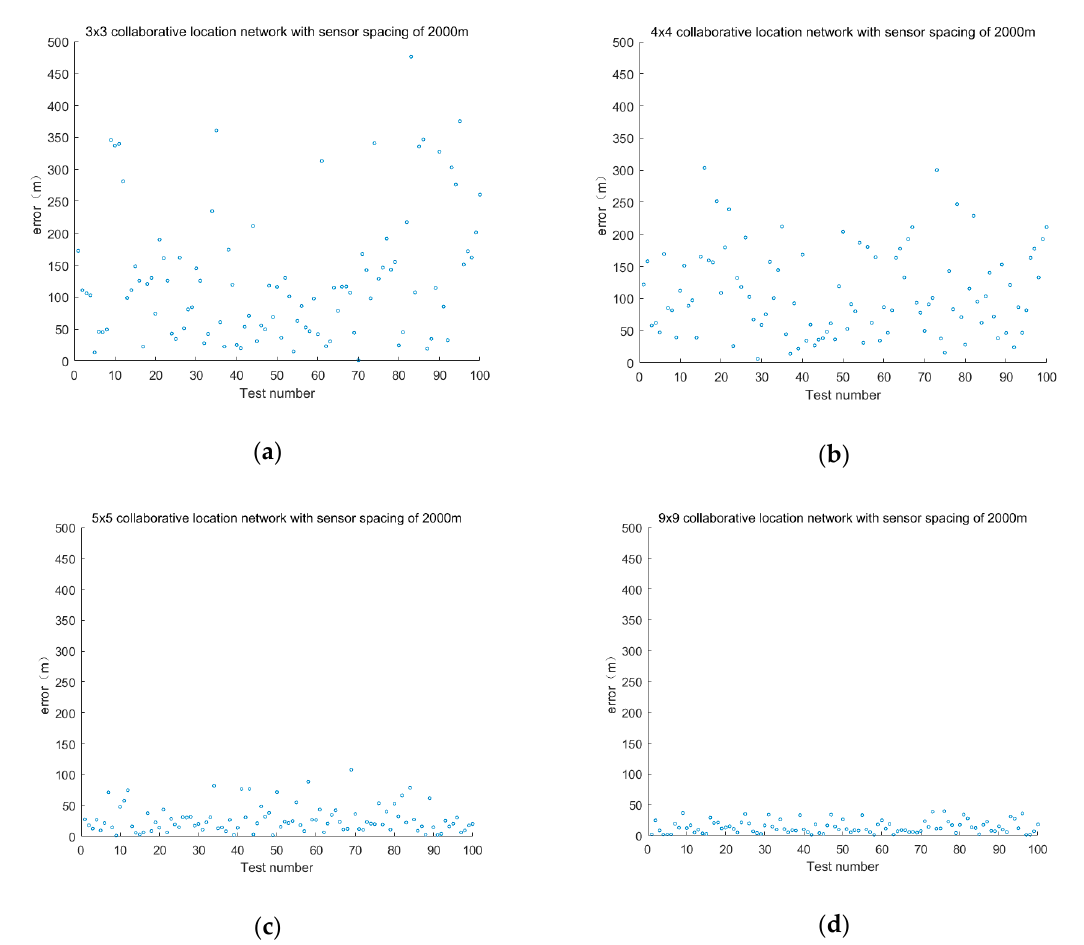
Figure 11. Positioning error of cooperative location network with different layouts of sensors at 2000 m intervals.